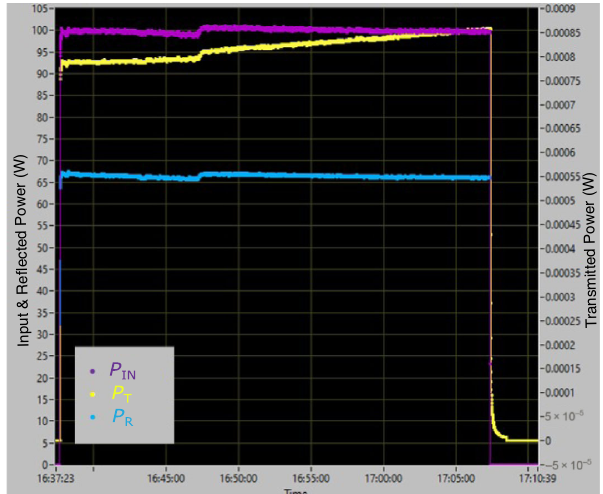
FIG. 3. Power versus time during cable testing for LCLS-II plasma processing: input power of 100 W for 30 min. The input and reflected power, P , P , respectively, follow the left y axis, IN R while the right y axis refers to the transmitted power P